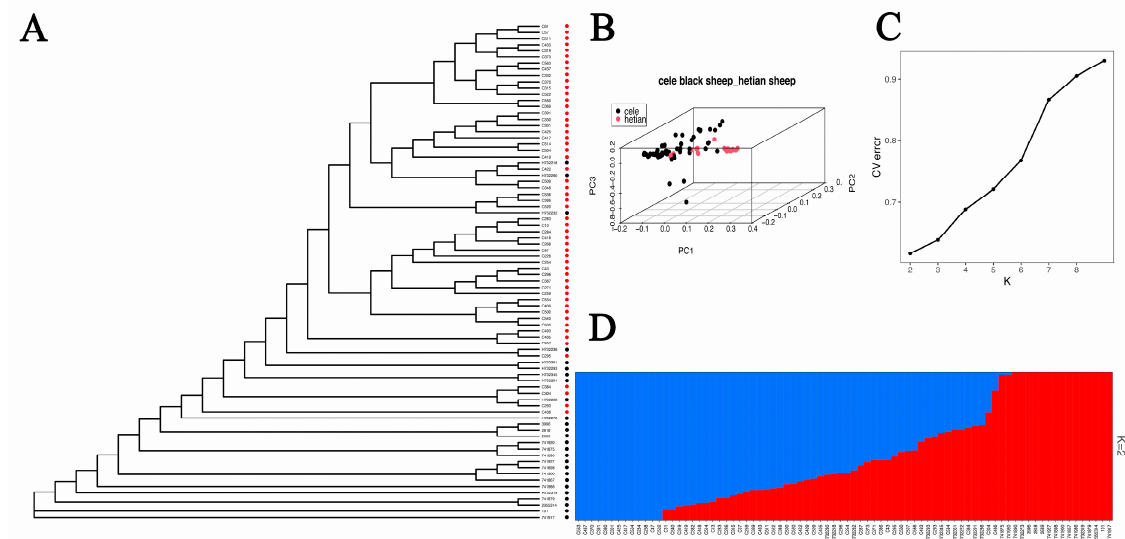
Figure 2. ( A ): Phylogenetic tree: red circles represent Cele black sheep, black circles represent Hetian sheep. ( B ): Principal component analysis. ( C ): Cross validation errors of ancestral clusters K. ( D ): Population structures with number of ancestral clusters K equaling two. Each color represents one ancestral cluster. The length of colored segments represents corresponding ancestry attributions.